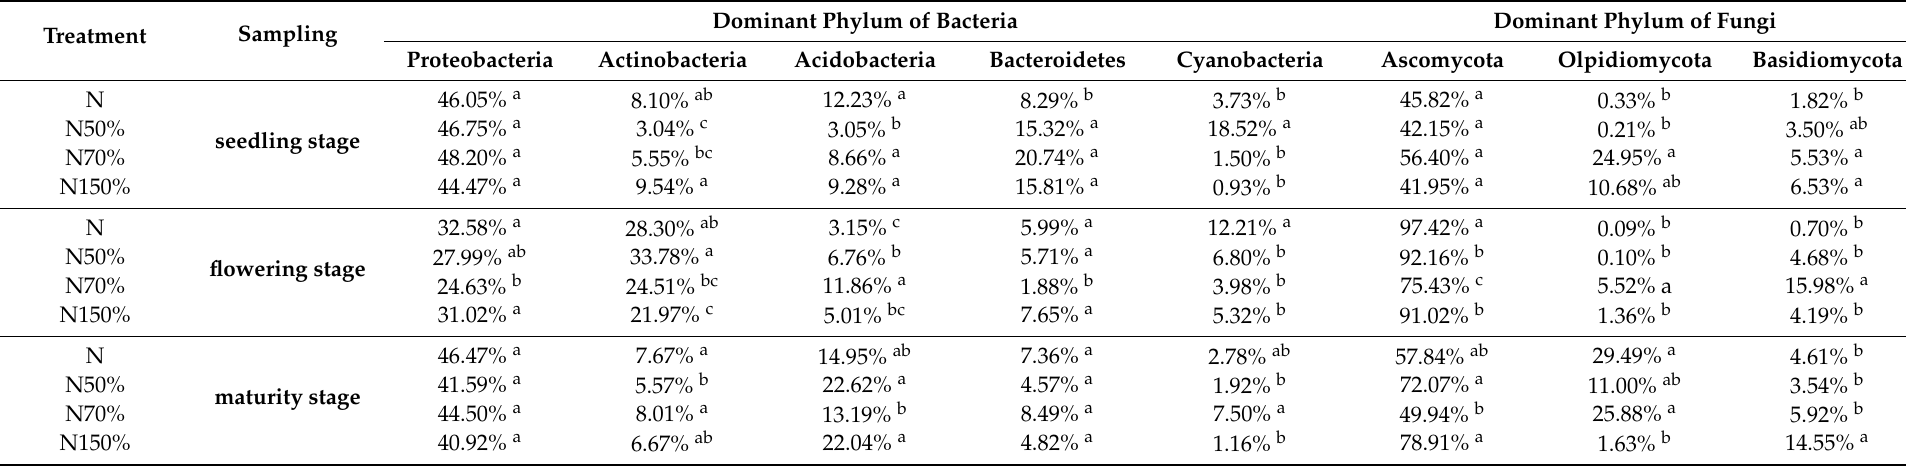
Table 1. Analysis of the significance of differences between dominant phyla treatments in the rhizosphere samples of oilseed rape at seedling, flowering and mature